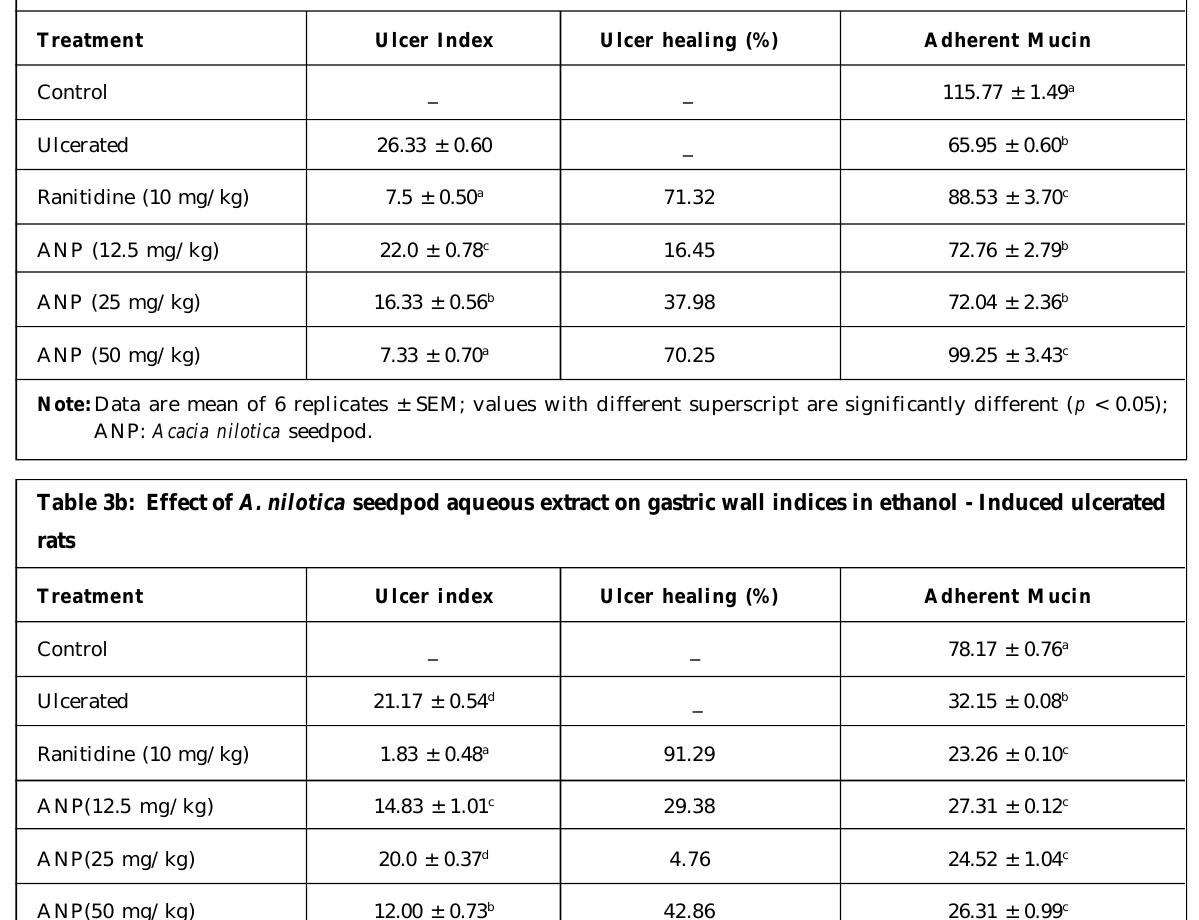
Table 3a. Highest reduction in ulcer index was observed in rats treated with 50 mg/kg bw of the extract